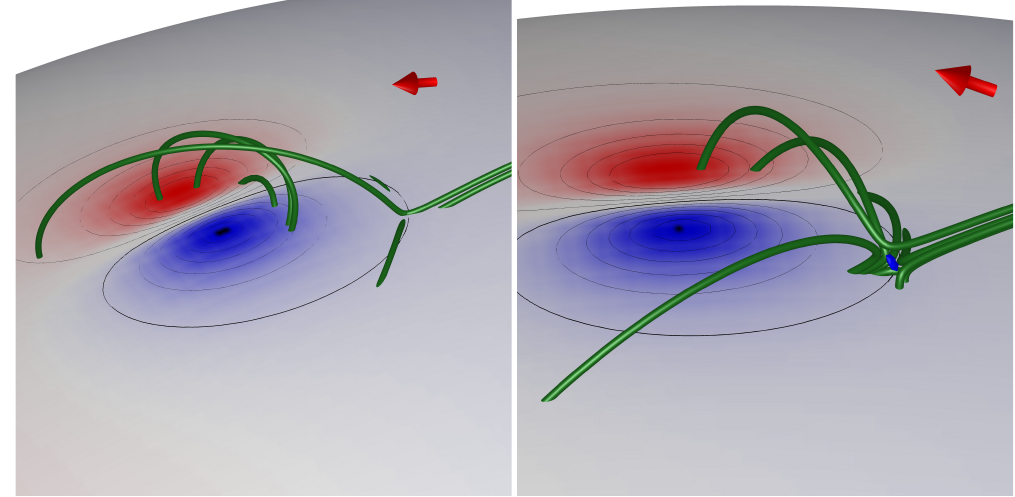
Fig. 7. Magnetic field lines around the polarity inversion line for 20 ◦ (left) and 25 ◦ latitude (right). The left plot shows a bald patch topology, while the right one shows a null point topology. The red arrows point north.